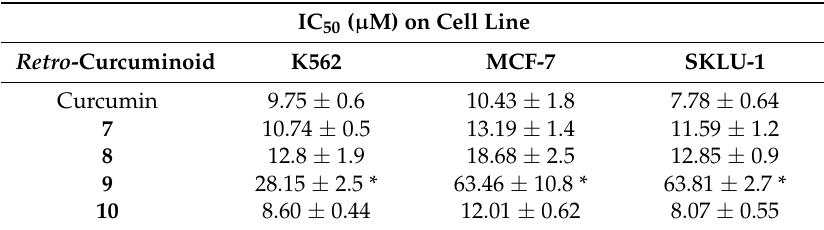
Table 3. Cytotoxicity screening of retro -curcuminoids 7 , 8 , 9 , and 10 .